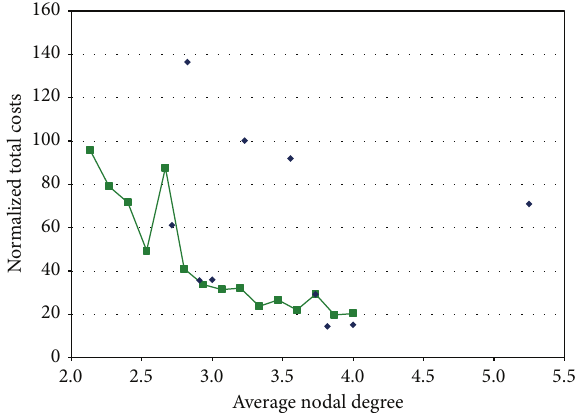
Figure 20: Normalized SBPP SCA spare capacity costs.